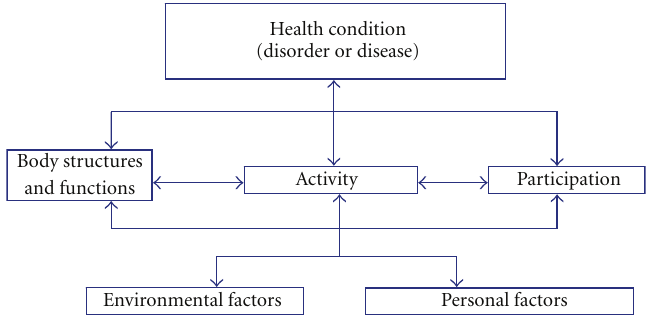
Figure 1: World Health Organization model of the international classification of functioning, disability and health for children and youth (ICF-CY). Body functions are physiological functions of body systems (including psychological functions). Body structures are anatomical parts of the body such as organs, limbs, and their components. Impairments are problems in body function or structure such as a significant